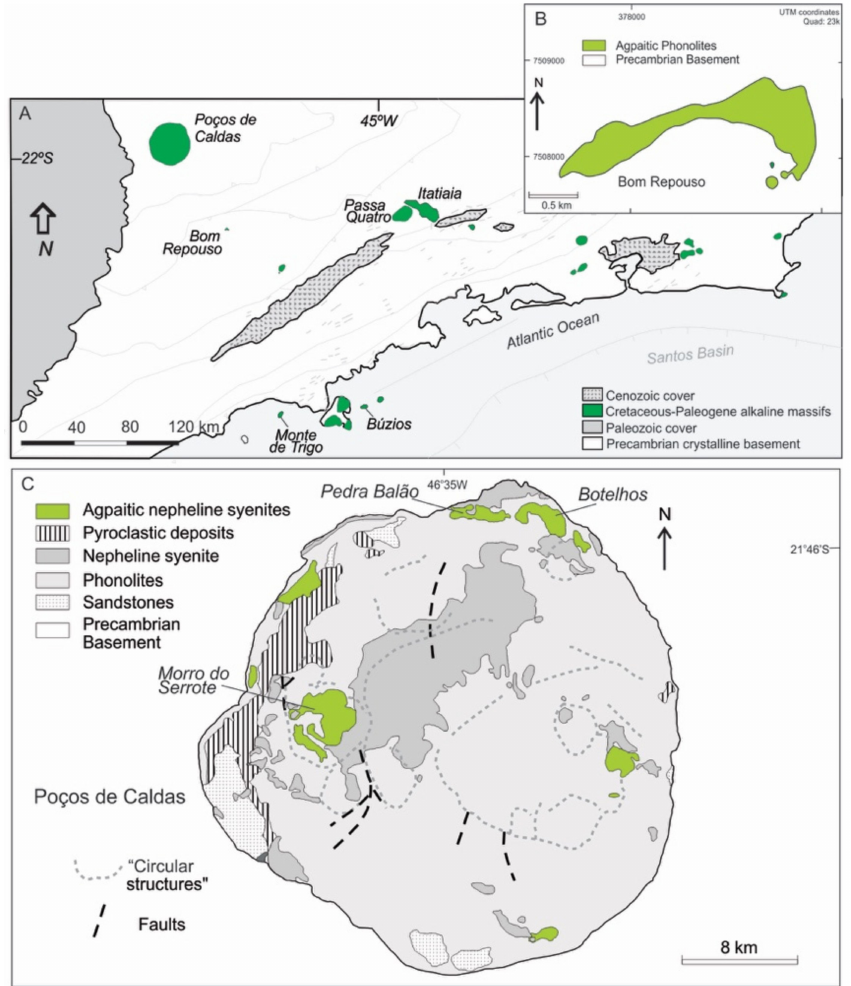
Figure 2. ( A ) Simplified geological map of the Serra do Mar alkaline province and surrounding areas in southeastern Brazil [46], indicating the location of studied intrusions. ( B ) Geological map of the Bom Repouso occurrence, formed solely by agpaitic rocks [21]. ( C ) Geological map of the Poços de Caldas massif, indicating the mapped units of agpaitic bodies